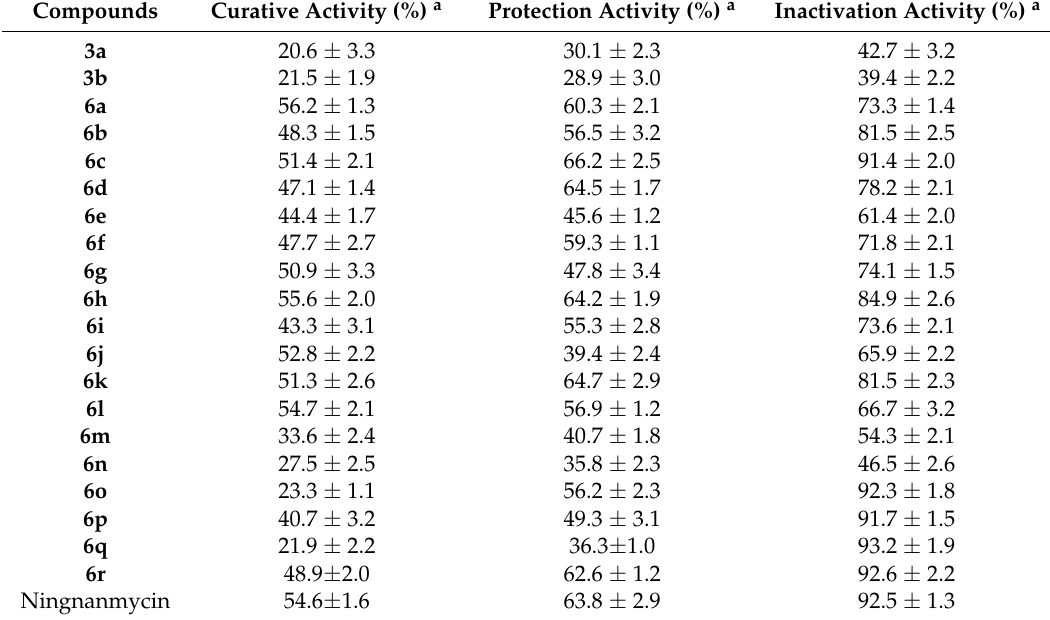
a Average of three replicates.